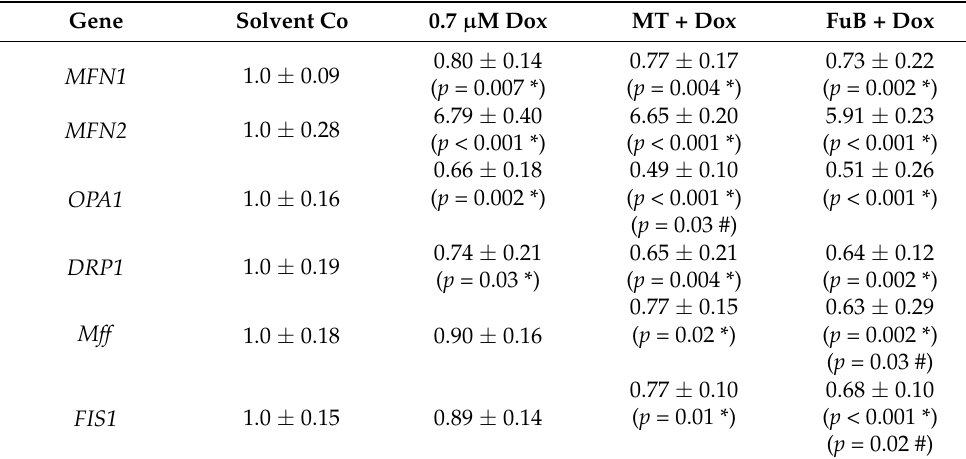
Table 2. Mitochondria fusion and fission related mRNA expression.